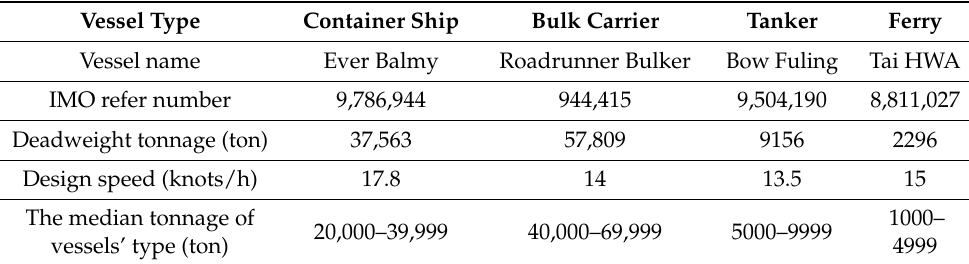
Table 1. The characteristics of the vessel types used in this study. Vessel Type Container Ship Bulk Carrier Tanker Ferry Vessel